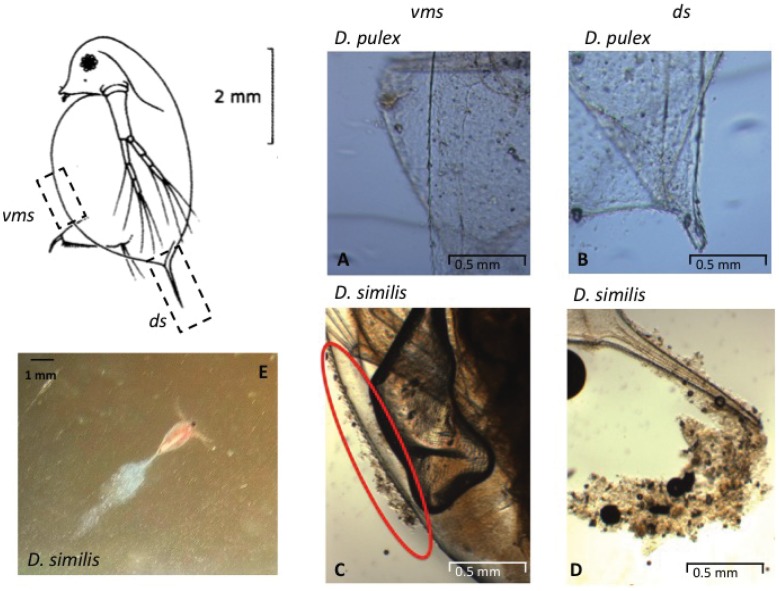
Representative image of distal spine (ds) and ventral margin of the shield (vms) in D. pulex and Daphnia similis exposed to 10 mg.L−1 of CeO2 NPs for 48 h.Note the accumulation of particles onto the cuticle of D. similis. The optical image (E) represents the D. similis after 48 h exposure to 10 mg.L−1 of CeO2 NPs.